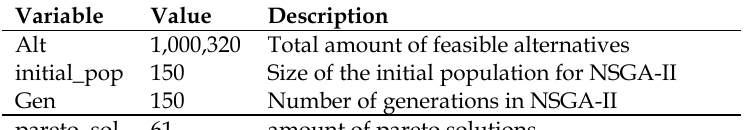
Table 9. Amount of Pareto solutions obtained after NSGA-II (150